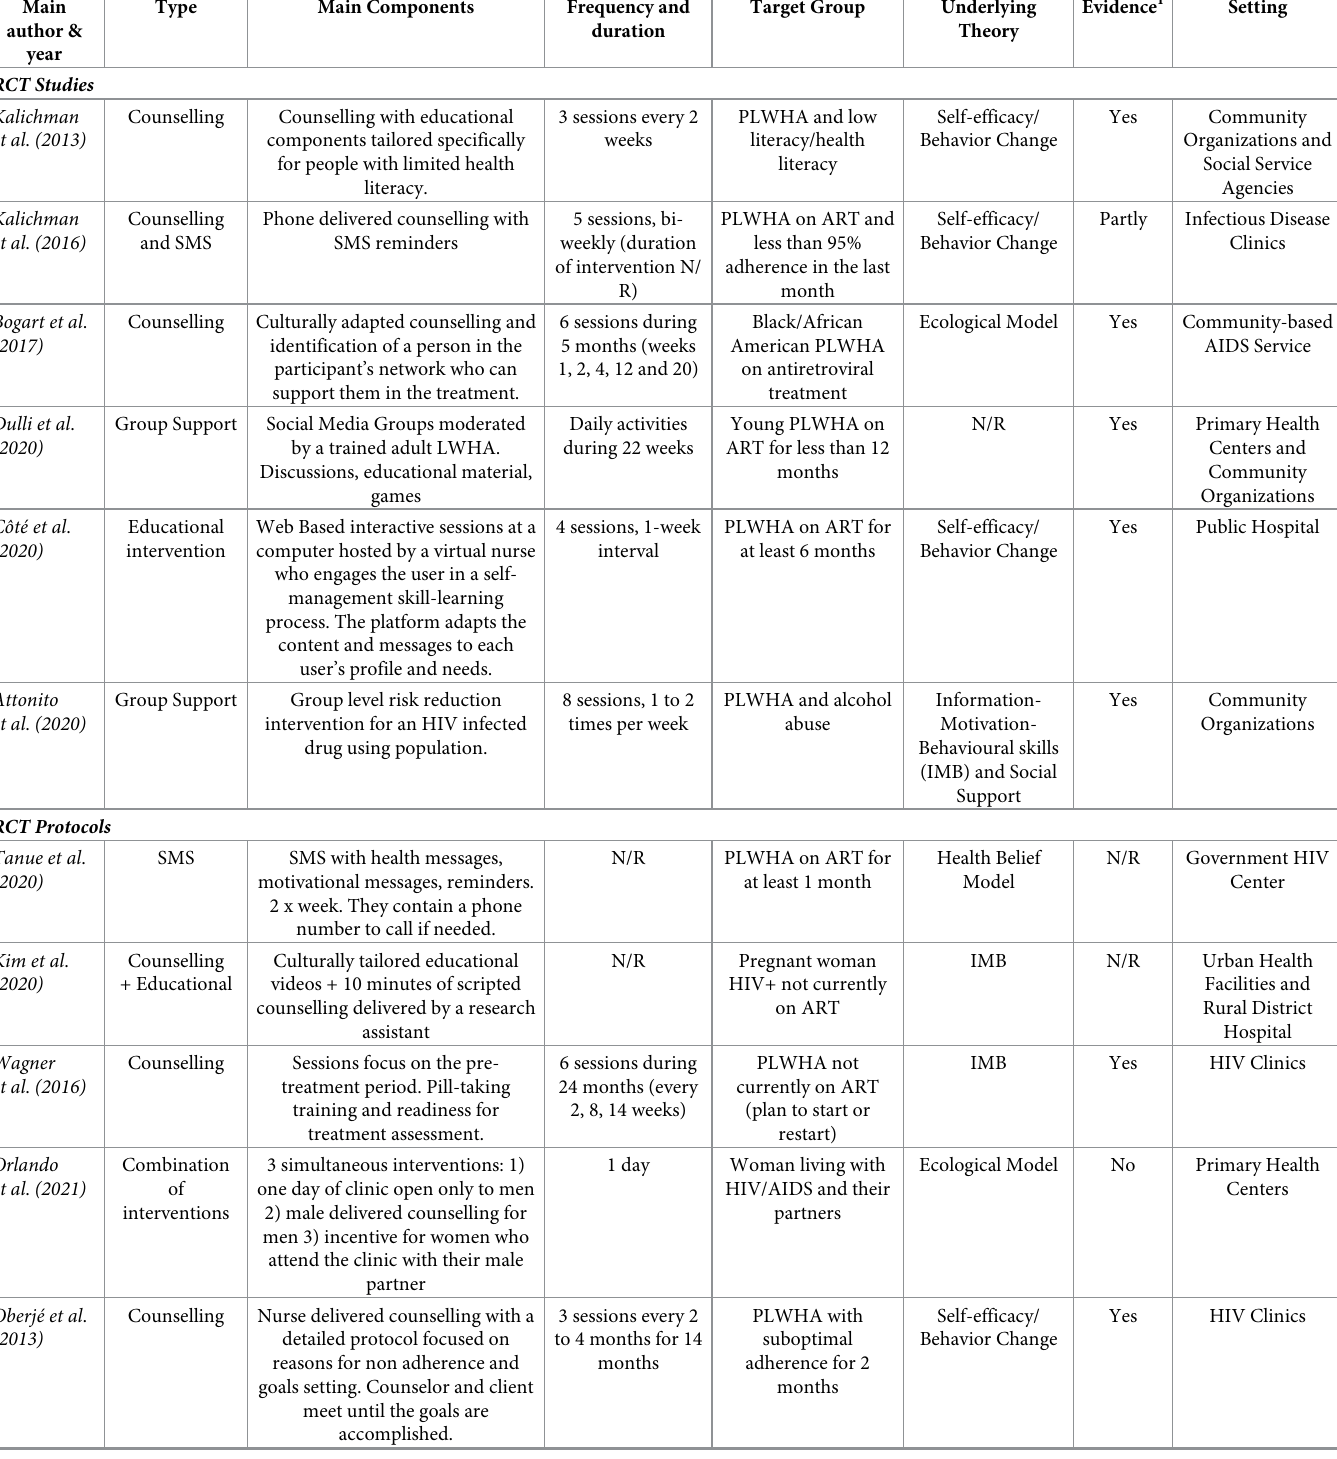
Table 3. Interventions